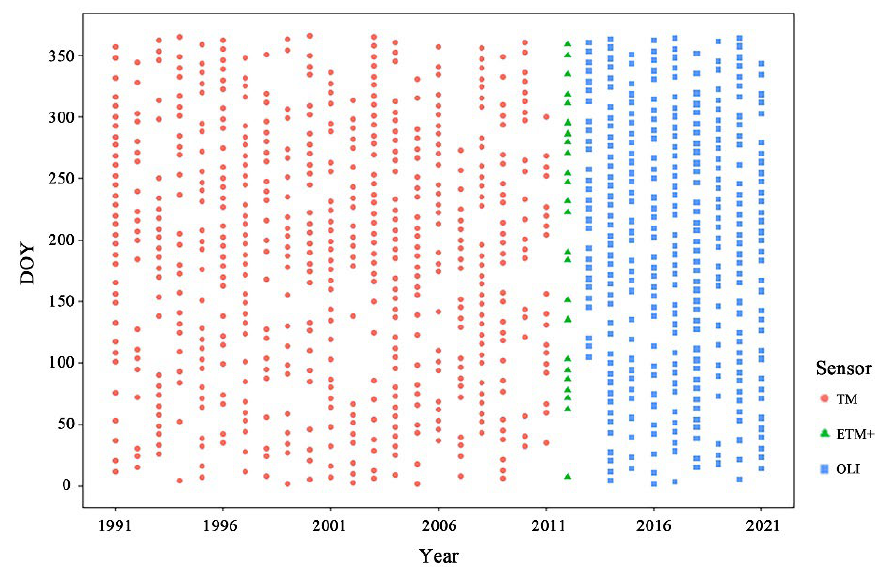
Figure 2. The collected Landsat imagery for Haitan Island by day of year (DOY) from 1991 to 2021. Image preprocessing, including image time screening, cloud and cloud shadow re- moval, multi-dimensional median (medoid) technique, and time series interpolation,